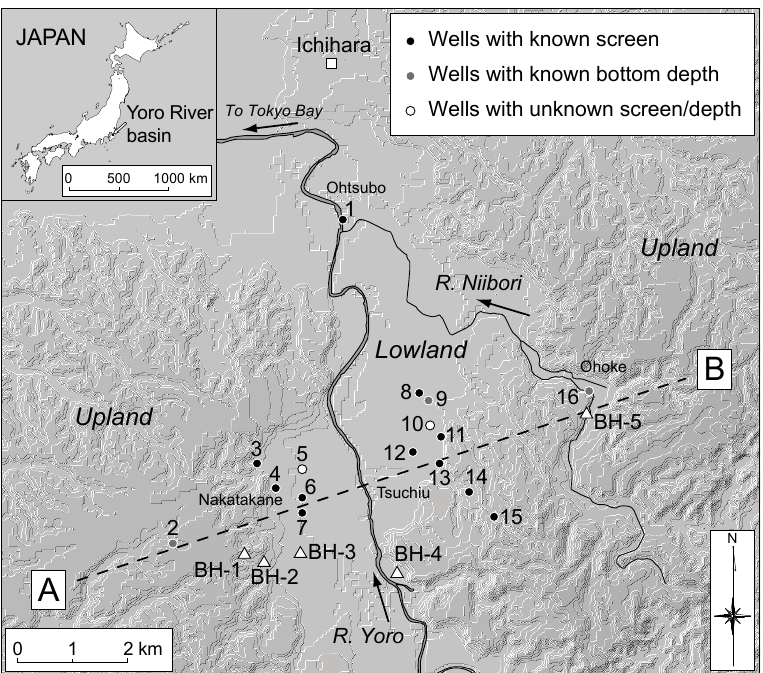
Figure 2. Locations of sampled irrigation wells in the Yoro River basin. Open triangles indicate selected borehole locations from Kondoh (1985) [30] and Chiba Prefectural Research Institute for Environmental Pollution (1974)